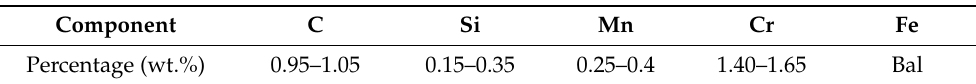
Table 1. The chemical composition of the Ti6Al4V disc. Component Al V Fe Ti Percentage (wt.%) Table 2. The chemical composition of the Gcr15 ball. Component C Si Mn Cr Fe Percentage